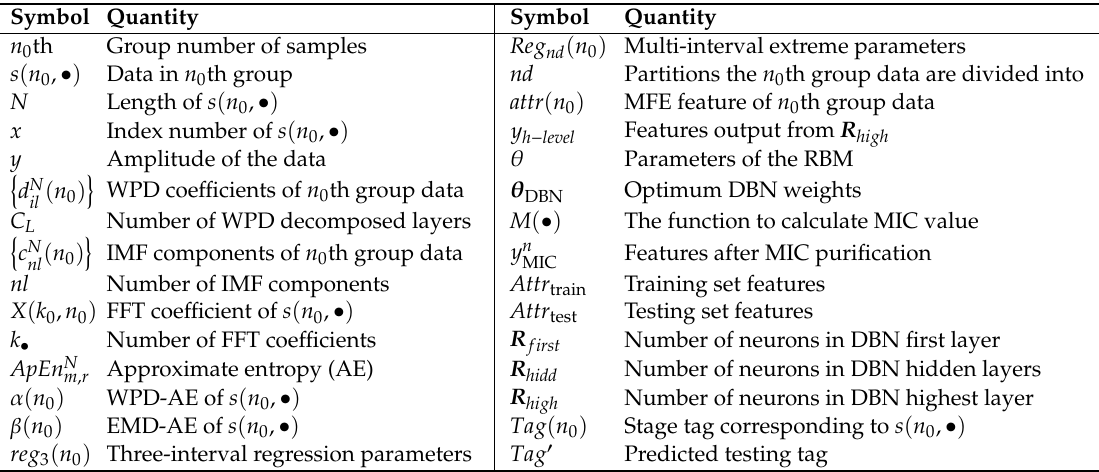
Table A1. Main definitions of the